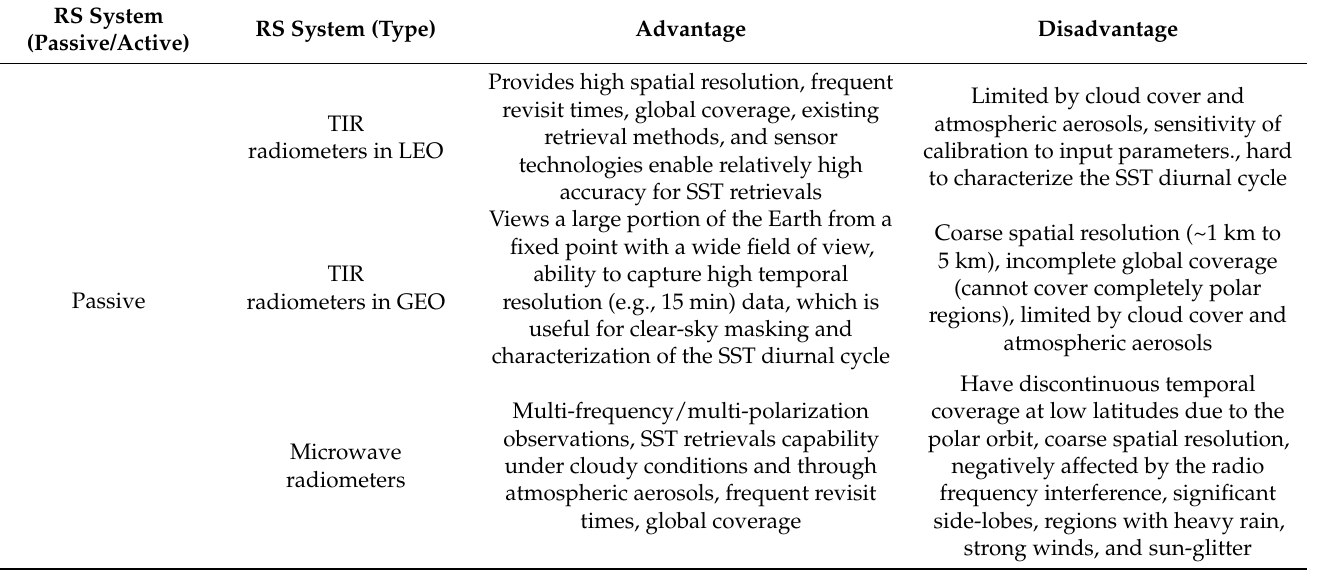
Table 3. Different RS systems for SST estimation along with their advantages and